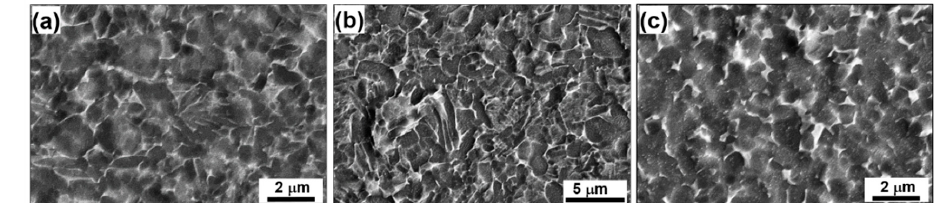
Figure 3. Typical SEM micrographs showing the microstructure distribution in the thickness direction of the stir zone: ( a ) Upper section, ( b ) mid-thickness, and ( c ) bottom section. Note the difference in magnification.